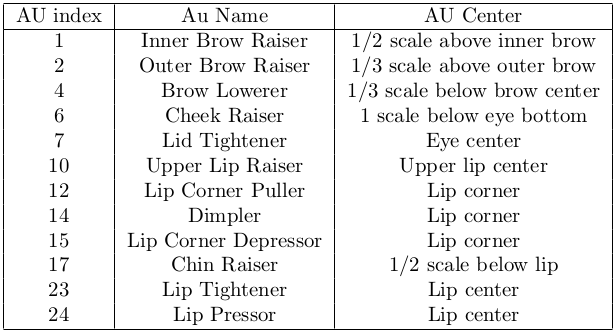
Table from the paper: EAC-Net: A Region-based Deep Enhancing and Cropping Approach for Facial Action Unit Detection
Table text:
AUindex
AuName
AUCenter
1
InnerBrowRaiser
1/2scaleaboveinnerbrow
2
OuterBrowRaiser
1/3scaleaboveouterbrow
4
BrowLowerer
1/3scalebelowbrowcenter
6
CheekRaiser
1scalebeloweyebottom
7
LidTightener
Eyecenter
10
UpperLipRaiser
Upperlipcenter
12
LipCornerPuller
Lipcorner
14
Dimpler
Lipcorner
15
LipCornerDepressor
Lipcorner
17
ChinRaiser
1/2scalebelowlip
23
LipTightener
Lipcenter
24
LipPressor
Lipcenter